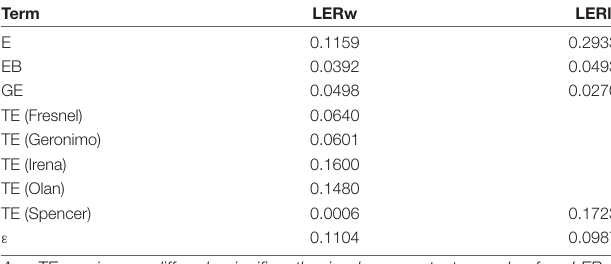
TABLE 5 | Standard deviations estimated for residues on random terms [environment (E), wheat genotype × environment interaction (GE), legume tester variety × environment interaction (TE), and block (EB)].